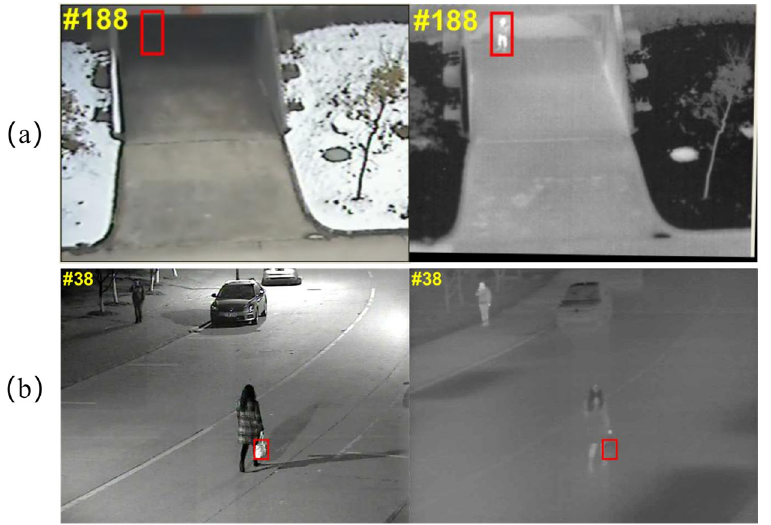
Figure 1. Illustration of the advantages of RGB and infrared modalities. ( a ) The advantage of thermal infrared modality over RGB modality. ( b ) The advantage of RGB modality over thermal infrared modality.